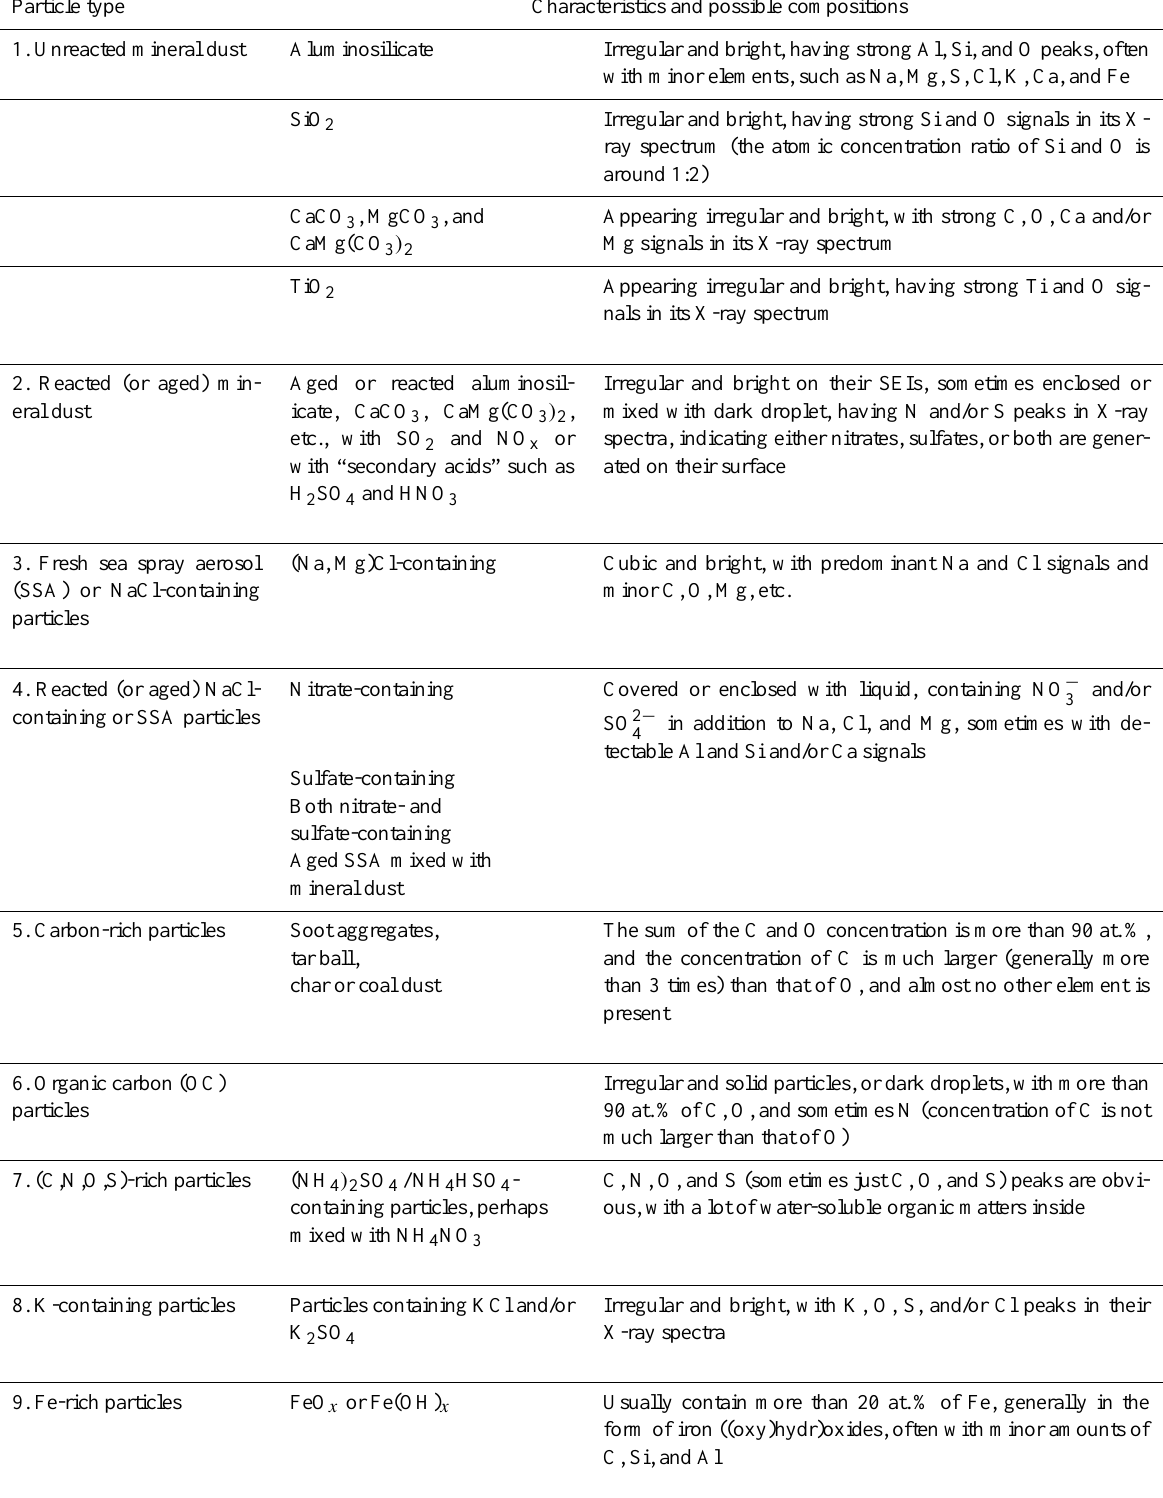
Table 3. Classification of the aerosol particles based on their SEIs and X-ray spectral